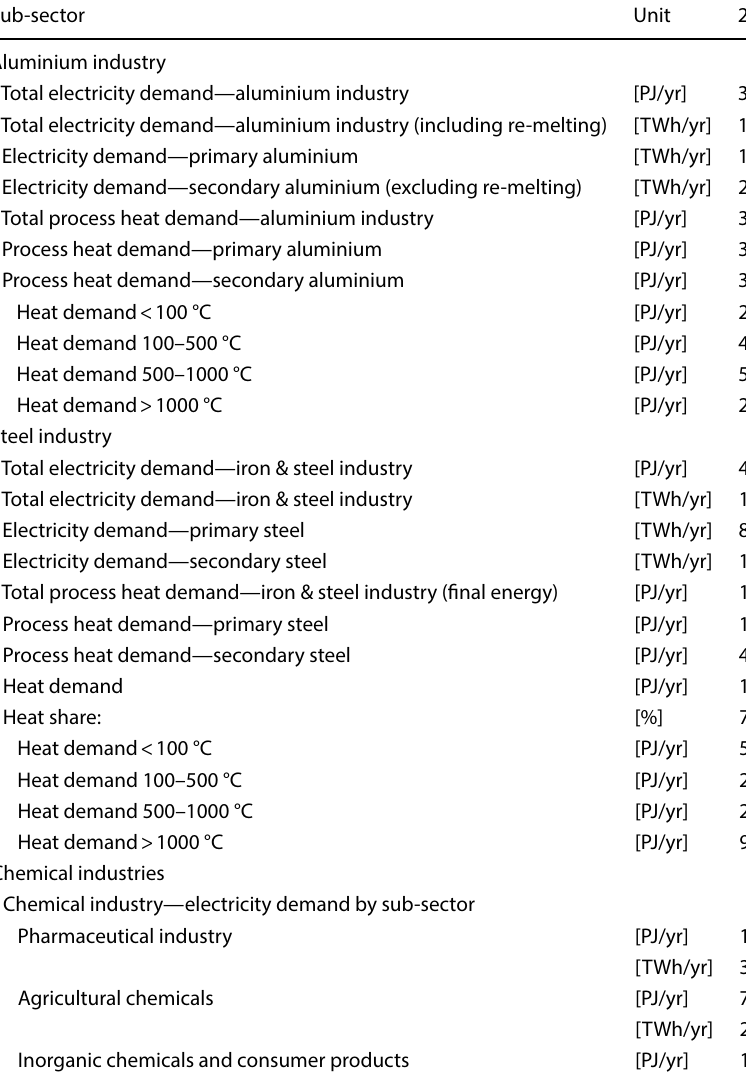
Table 14 Projected electricity and process heat demands for the aluminium, steel, and chemical industries to 2050